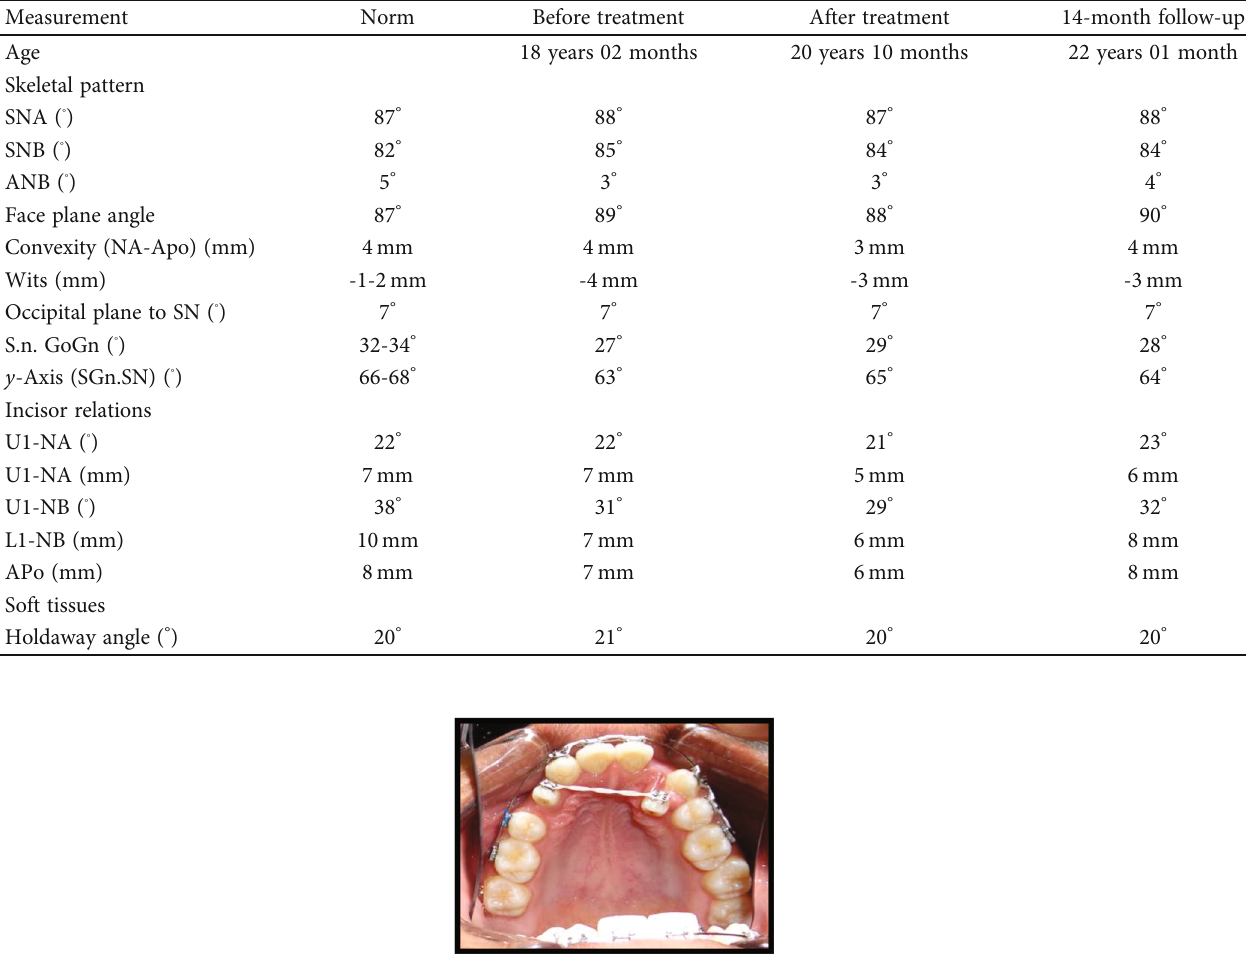
Table 1: Lateral cephalometric readings.